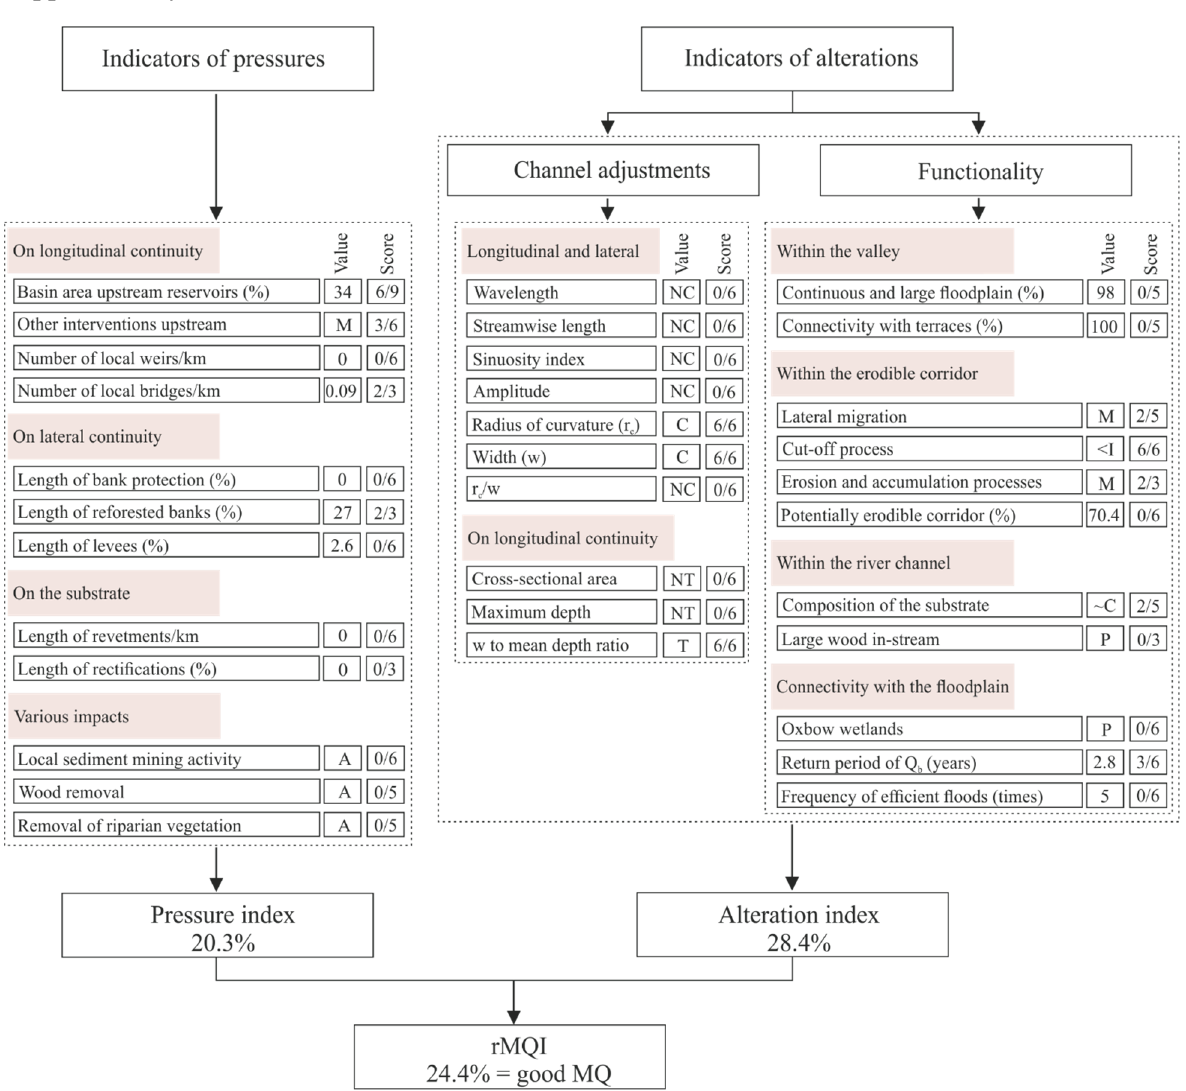
Figure 3. Results of Revisited Morphological Quality Index (rMQI) protocol for the Lower Prahova River; a list of acronyms for values are provided in Supplementary